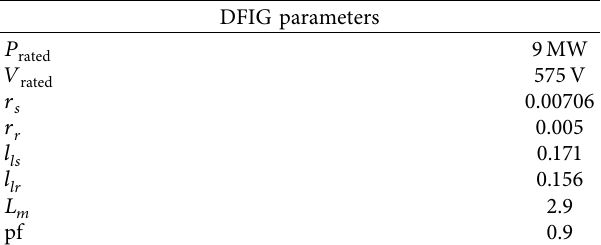
Table 7: Wind generator parameters